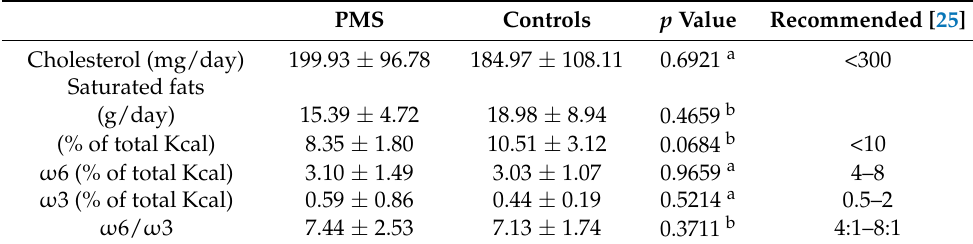
Table 4. Estimated daily lipid intakes in participating women. PMS Controls p Value Recommended [25] Cholesterol (mg/day) 199.93 ± 96.78